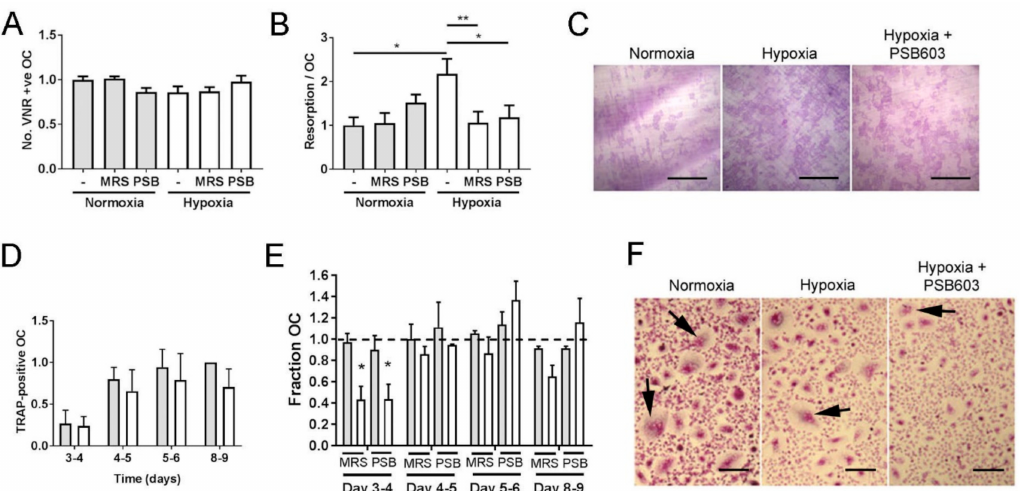
Figure 2. A 2B receptor inhibitors reduce osteoclast formation and activity in hypoxic culture. Quantified e ff ect of 24 h exposure of mature human osteoclasts cultured on dentine to MRS1754 (2.5 µ M) or PSB603 (10 nM) with respect to ( A ) osteoclast survival (no. VNR-positive osteoclasts present) and ( B , C ) the area of dentine resorbed per osteoclast. ( n = 6). Scale bars = 700 µ m. ( D ) E ff ect of 24 h acute hypoxic exposure (2% O 2 , white bars) on the number of TRAP-positive multi-nucleated osteoclasts formed during di ff erentiation ( n = 6) and ( E , F ) the additional e ff ect of MRS1754 or PSB603 on osteoclastogenesis. Grey bars represent normoxia. ( n = 3), * p < 0.05, ** p < 0.01. Arrows indicate multi-nucleated osteoclasts, scale bars = 100 µ